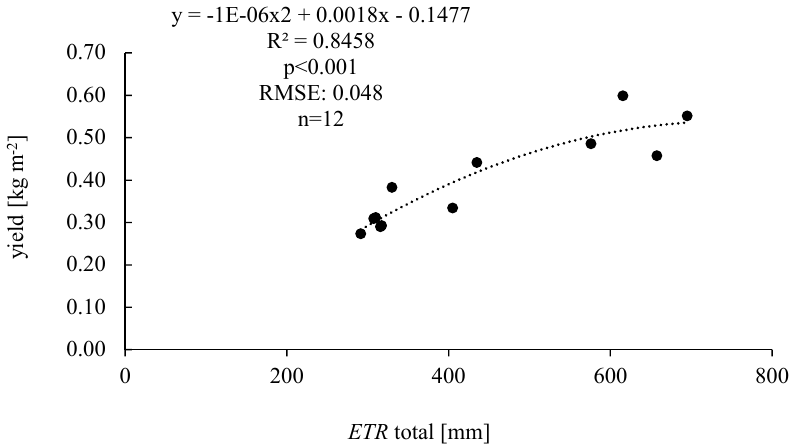
Figure 12. Relationship between seed yield (kg m − 2 ) and total seasonal evapotranspiration ( ETR ; mm) of two soybean varieties over the 2017 and 2018 growing seasons.